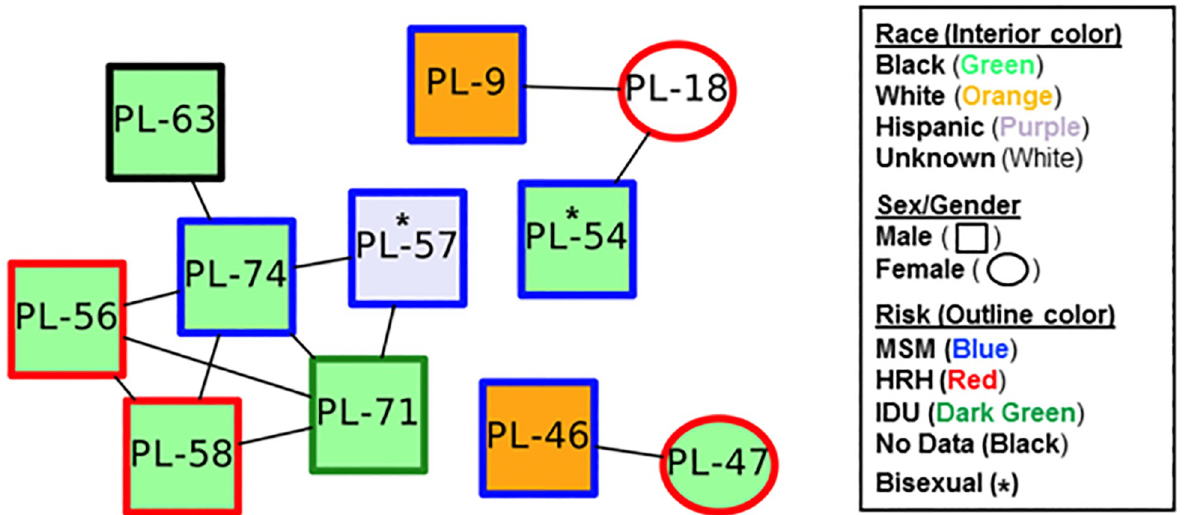
Fig 5. Transmission clusters were created using HIV-TRACE software based on RT NGS sequences generated using the � 20% frequency cutoff along with participants’ race, sex/gender and HIV risk categories.